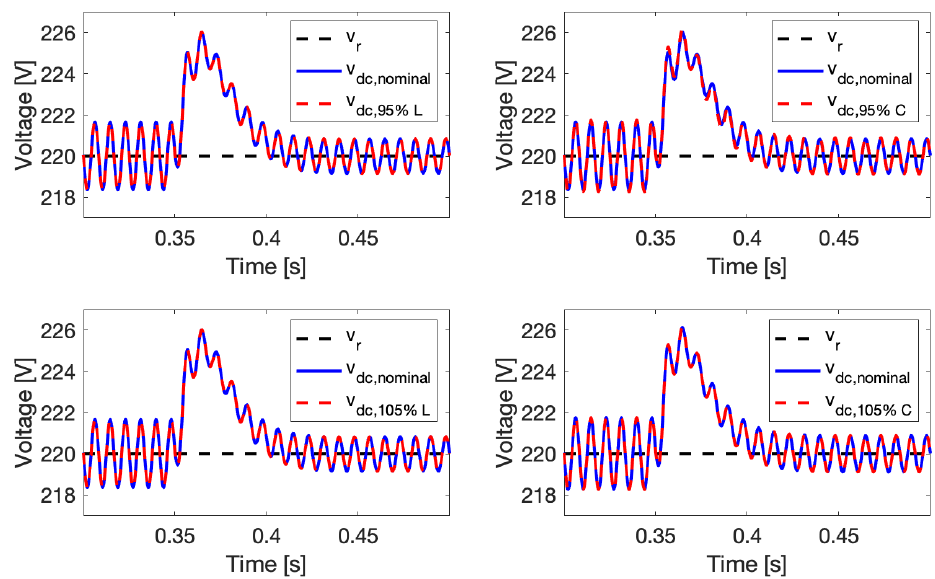
Figure 20. Evaluation of the controller robustness to variations on the inductor and